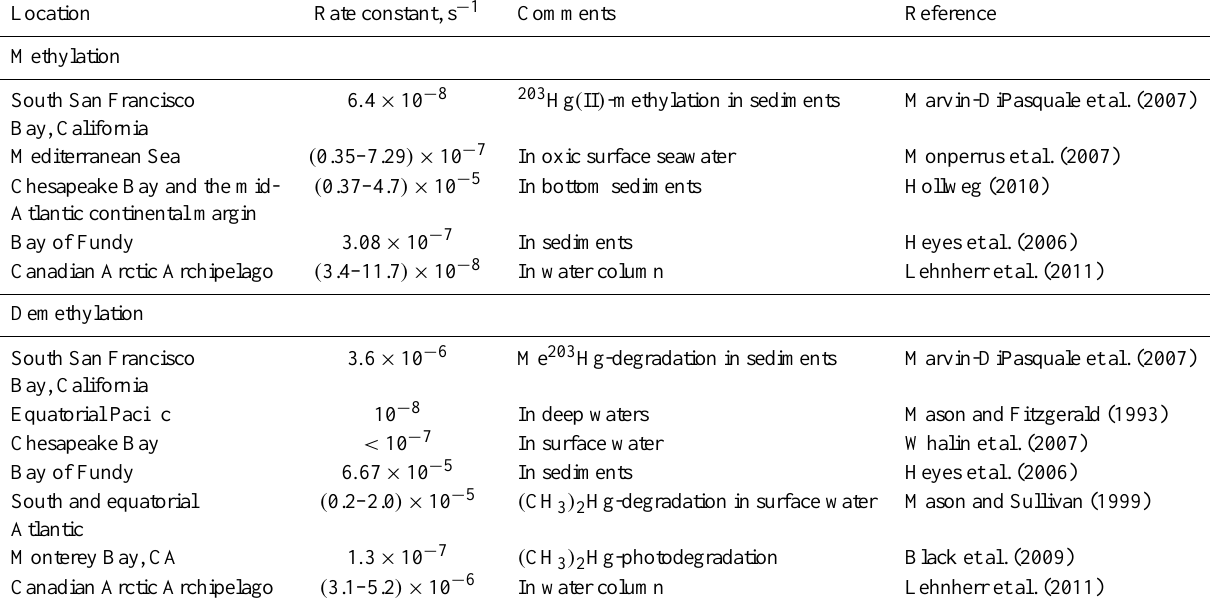
Table 5. Rate constants of mercury methylation and demethylation in seawater and